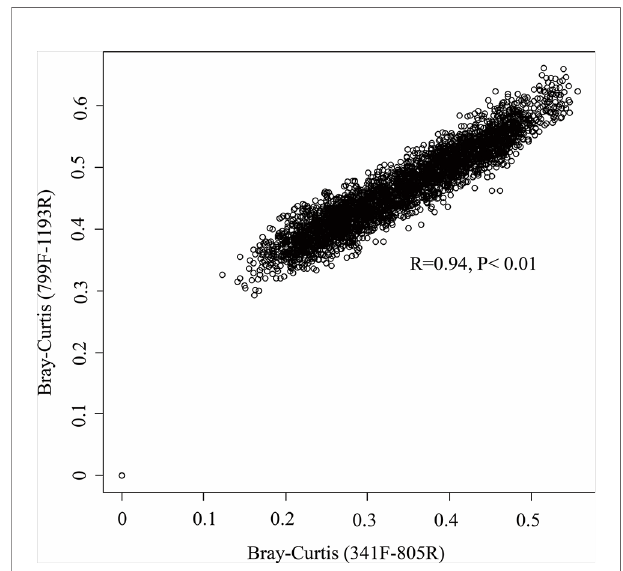
FIGURE 6 | Relationship between the community composition as determined by the primer pairs 799F/1193F and 341F/805R. Mantel correlation was performed on the Bray – Curtis matrix at the OTU